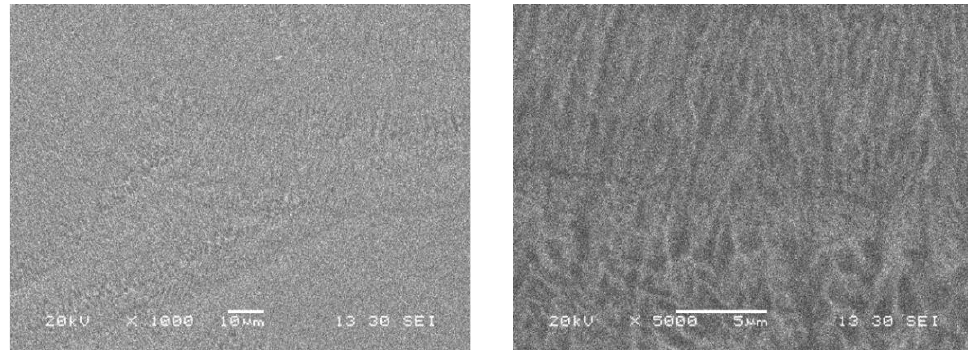
Figure 11. Microstructure on the XY plane ×1000 ( left ), ×5000 ( right ).